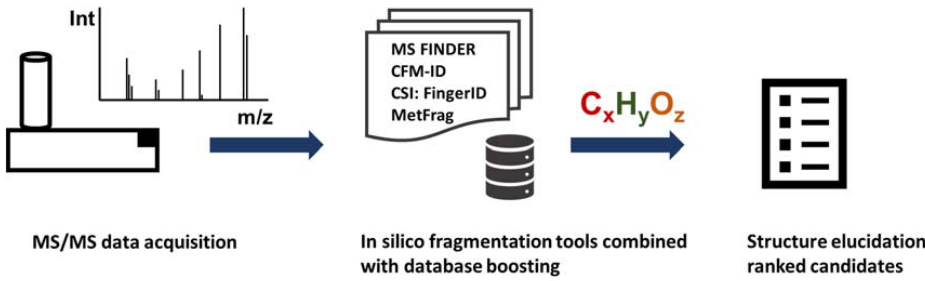
Figure 2. In silico fragmentation tools such as MS-Finder, CFM-ID, CSI:FingerID and Metfrag utilized known compounds from structure databases to calculate fragments compare those theoretical fragmentations against experimental spectra. When combined with MS/MS database search and utilizing additional metadata annotation rates can be increased